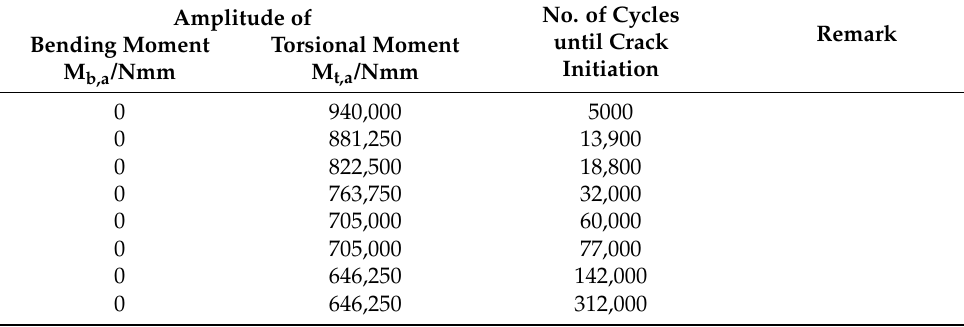
Table A2. Test results for pure torsion tests.